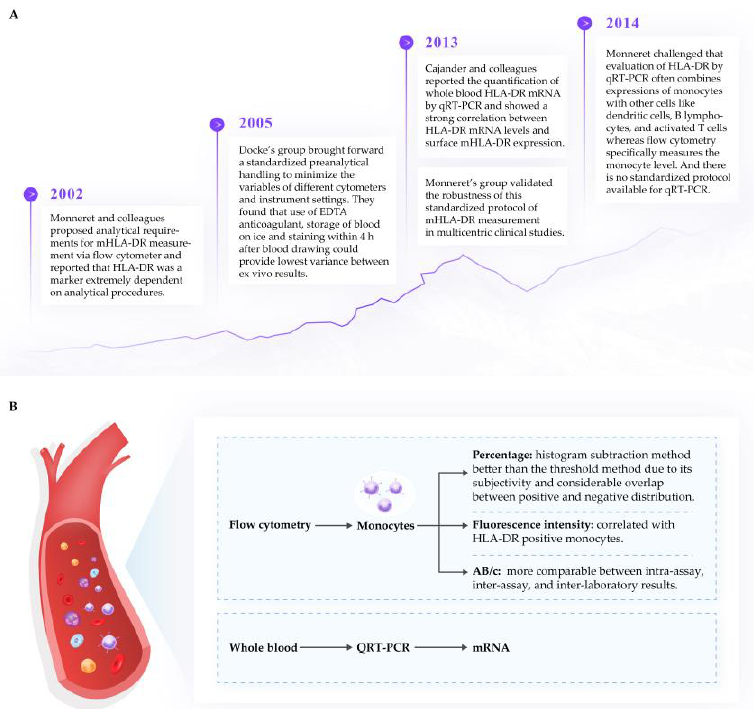
Figure 2. Measurement of mHLA-DR expression. ( A ) Measurement of mHLA-DR expression and requirements for sample handling procedures [97–101]. ( B ) Relationship of units of mHLA-DR expression to different measurement